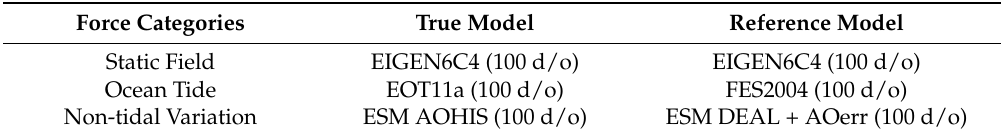
Figure 1. Processing flow of the forward and the backward simulations. Table 2. Background models for numerical simulation. True models are used for simulated observations generation while the reference models are applied to gravity field recovery.